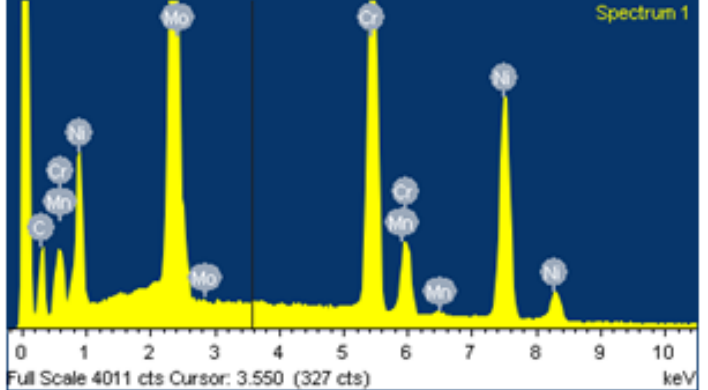
Figure 20. Spectrum 1 of EDX analysis.